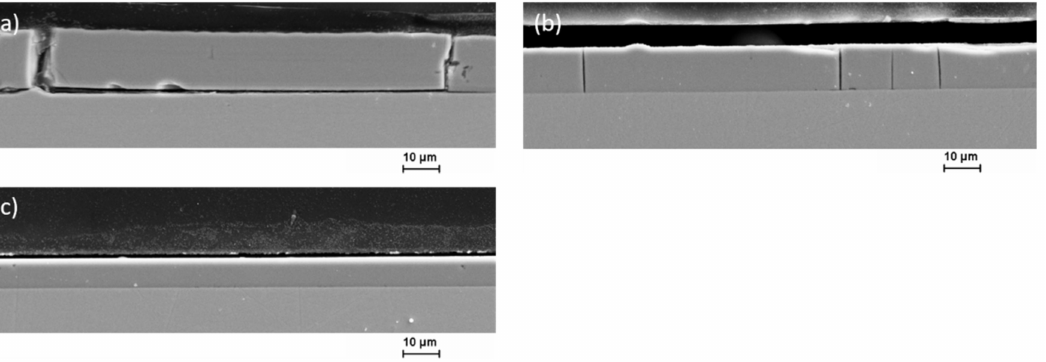
Figure 15. Scanning electron microscopy micrographs of cross-sections of electrodeposited Fe-Cr-Ni coatings under PC conditions for three depositions: ( a ) first deposition (2 h of electrolyte use) with clear microcracks; ( b ) second deposition (4 h of electrolyte use) with several microcracks; and ( c ) third deposition (6 h of electrolyte use) with only a small layer thickness but without any microcracks.